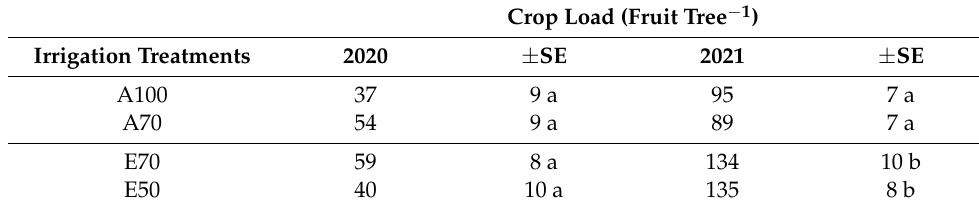
Table 2. Crop load determined at harvest (quantity of fruit per tree). Each value represents the average (+SE) of six and nine trees in 2020 and 2021, respectively. Different letters indicate significant difference at p < 0.05.